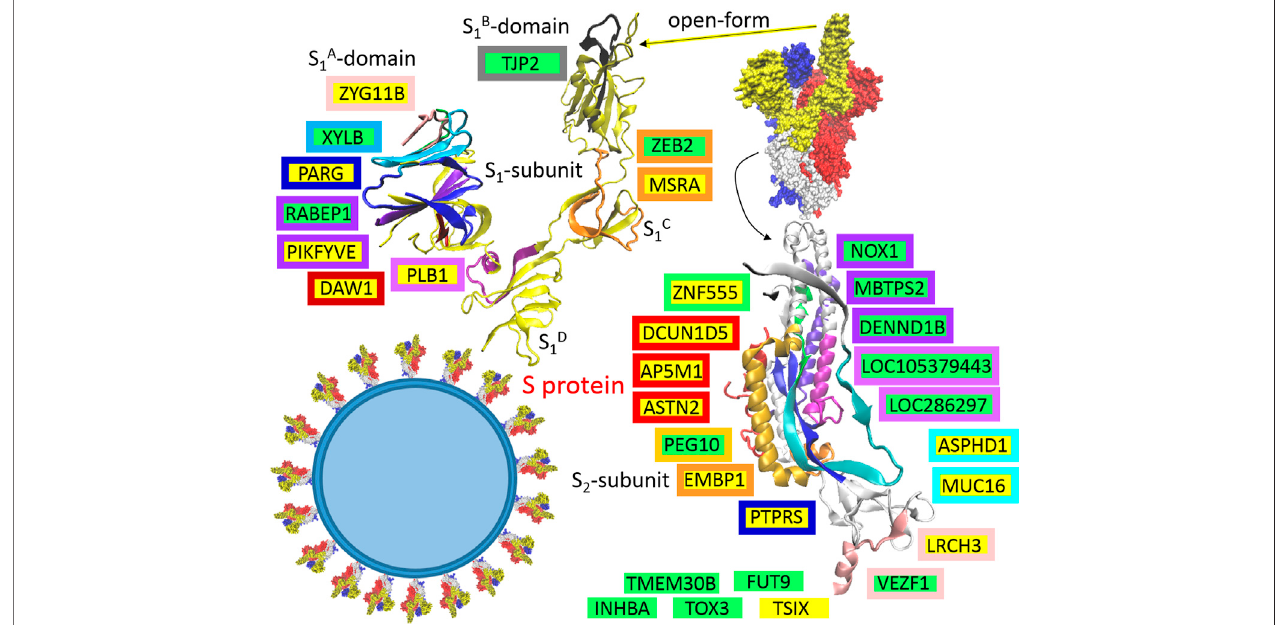
FIGURE2| Theidenti fi edsequencesinQHD43416(spikeprotein: S).Greenhighlightsshowthealignmentswiththecomplementsequence(post-transcriptionally repressed); yellow highlights show the alignments with the reverse complement sequence (post-transcriptionally promoted). The position in the 3D structure (6VYB; Walls et al., 2020) is colored in the same color as the frame of the gene.